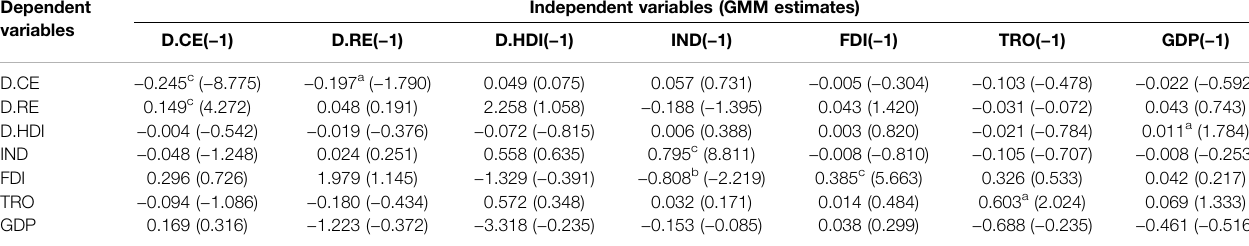
Independent variables (GMM